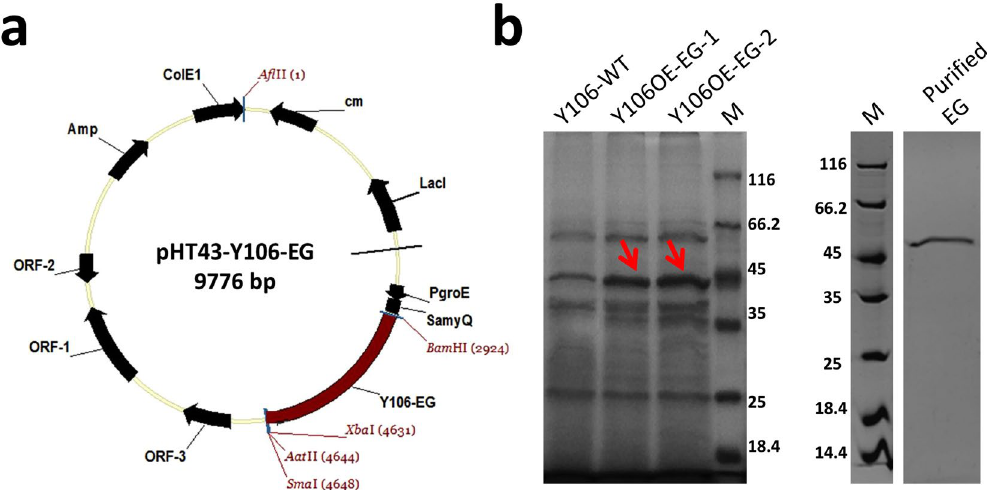
Figure 1. ( a ) Map of expression vector pHT43-Y106-EG (sub-cloning the alkali-tolerant Y106- eg in a shuttle vector pHT43), ( b ) Proteins detected by SDS-PAGE. Y106-WT: Crude enzyme of Bacillus subtilis Y106; Y106OE-EG-1/Y106OE-EG-2: Crude enzyme of Bacillus subtilis Y106OE-EG; Purified EG: EG purified from crude enzyme of Bacillus subtilis Y106OE-EG, M: protein molecular weight markers